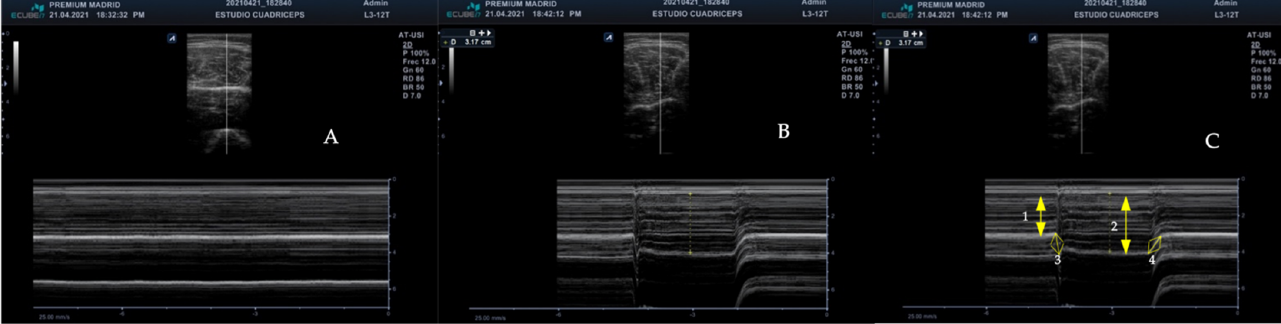
Figure 1. M-mode RFM measurements. Muscle at rest ( A ), muscle at contraction ( B ), and muscle at contraction with measurements ( C ) where: rest (1), contraction (2), muscle contraction time (3), and muscle relaxation time (4).